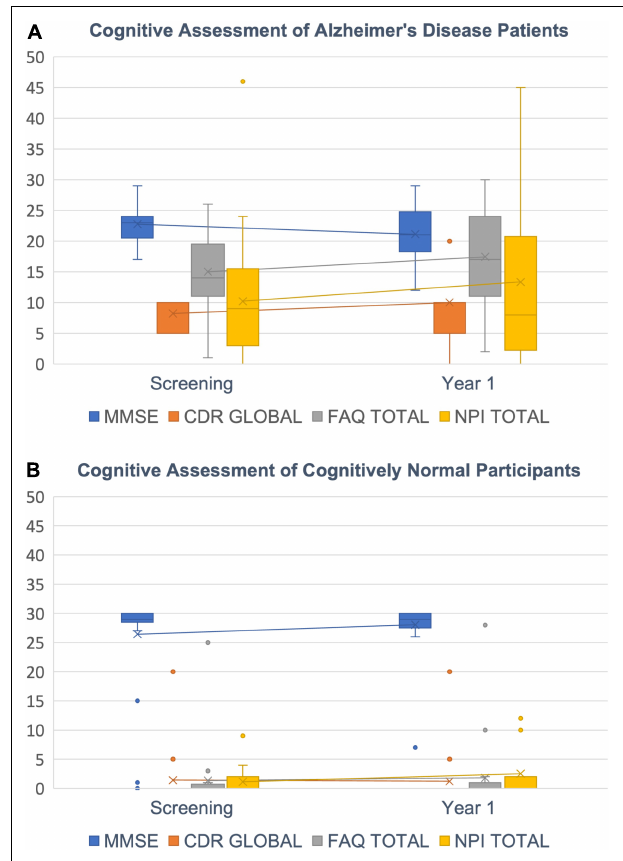
FIGURE 7 | Cognitive decline. (A) AD Patients’ decrease in cognitive abilities is indicated by a decreasing MMSE score (blue) and increasing CDR global (orange), FAQ total (gray) and NPI total scores (yellow). (B) CN subjects show scores around 30 for MMSE and close to zero for CDR global, FAQ total and NPI total as expected. Box plots with median (horizontal lines) percentiles (boxes), standard deviations (error bars) and outliers